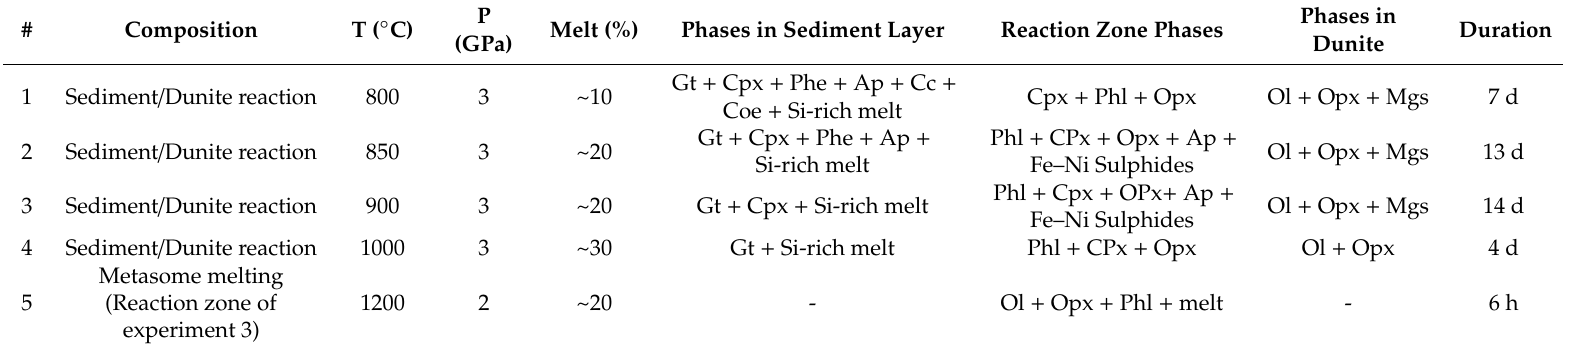
Table 1. Melting phase relations of reaction experiments and second-stage melting experiment.